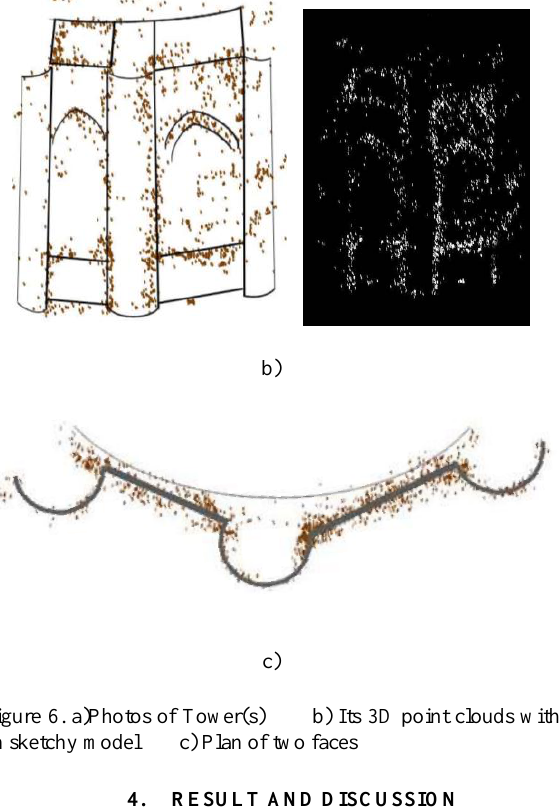
Figure 5. The excavation, its 3D point clouds and model Area of the excavation field was about 400m 2 . The 22 consequence images have been taken to cover all the area.